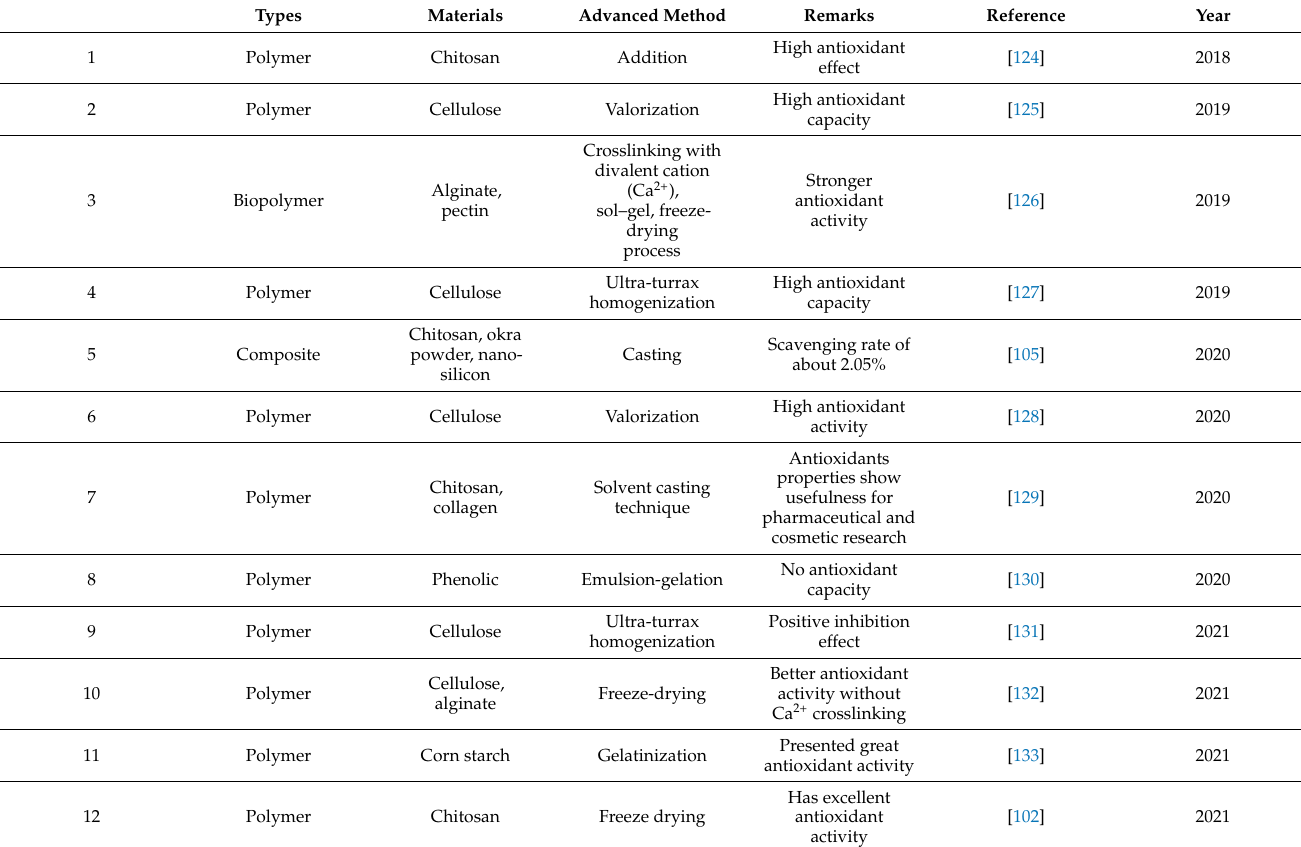
Table 4. Studies on anti-toxicities of